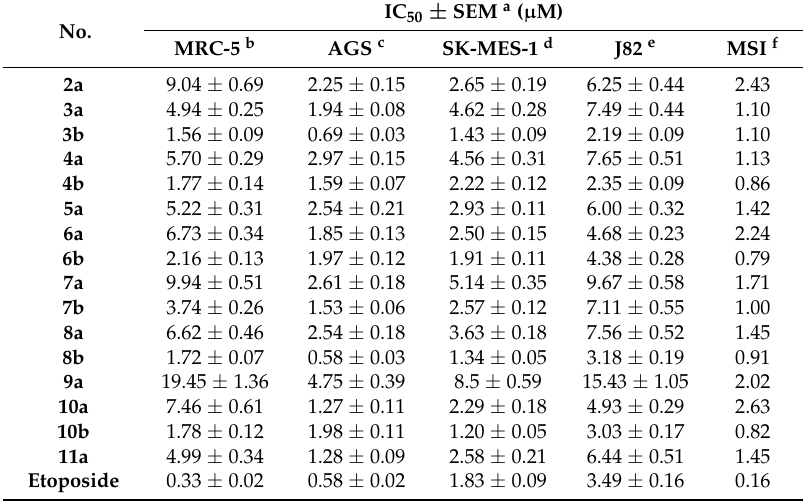
a Data represent average values of six independent determinations, SEM: standard error of the mean; b Normal human lung fibroblasts; c Human gastric adenocarcinoma cell line; d Human lung cancer cell line; e Human bladder carcinoma cell line; f MSI: Mean Selective Index = IC 50 values for fibroblasts/IC 50 values tumor